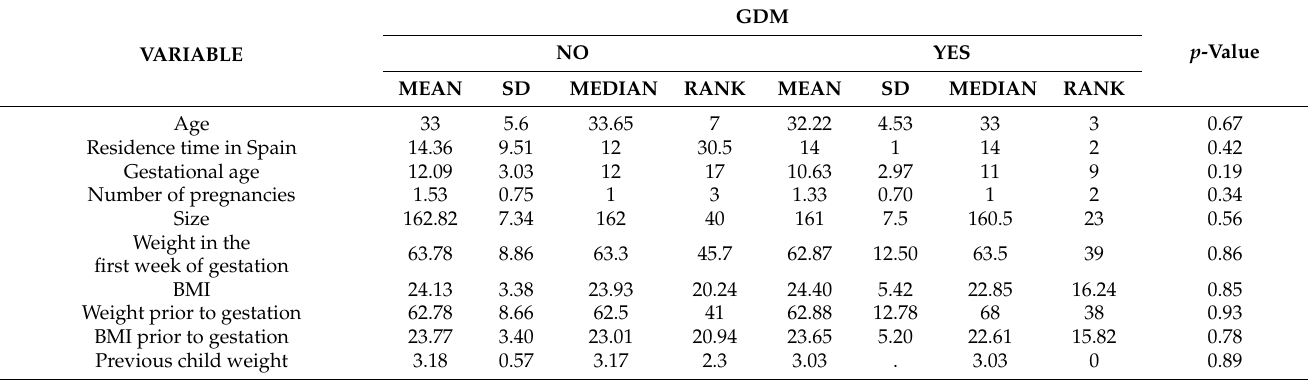
Table A2. Comparison of some demographic, anthropometric and previous obstetrical history data among women with GDM and normoglycemia.